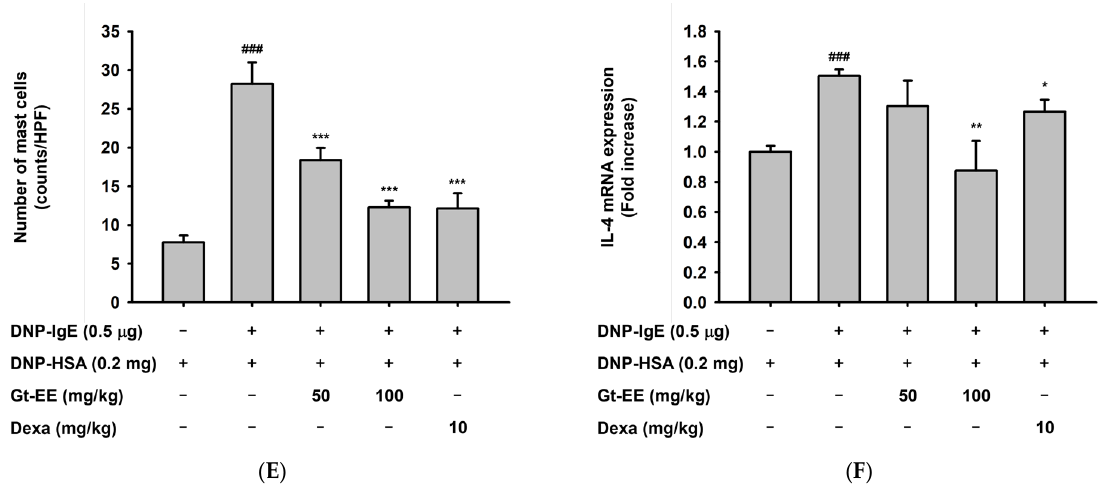
Figure 3. Effects of Gt-EE on PCA. ( A ) Experimental procedure for induction of PCA. Anti-DNP IgE and DNP-HSA were administered to the ears of BALB/c mice to induce PCA, and then the ears were stained with Evans blue dye. Gt-EE was orally administered every day for 5 days before PCA induction. Dexamethasone was used as the positive control. After euthanasia, the ears were dissected and soaked in formamide for extravasation of the Evans blue dye or fixed for histopathological analysis; ( B ) photographs of the Evans blue – stained ears and ear tissues stained with hematoxylin and eosin (H&E) or toluidine blue O. Histopathological variations and alterations in the mast cell counts due to IgE – antigen induction were assessed using H&E and toluidine blue O staining, respectively. The red arrows indicate toluidine blue O – stained mast cells; ( C ) absorbance of Evans blue extravasated from the mouse ears. Absorbance was measured at 620 nm. ( D ) The change in ear thickness was investigated using dial thickness gauges (PEACOCK, Japan). ( E ) The number of mast cells in the ear tissue was counted under a microscope at 400× magnification. ( F ) The mRNA expression of IL-4 in the mouse ears was measured using real-time PCR. After euthanasia, the ears were dissected and ground, and then total RNA was isolated for real-time PCR. ( C – F ) The results are presented as the mean ± standard deviation. ### p < 0.001 compared with the normal group, and * p < 0.05, ** p < 0.01, *** p < 0.001 compared with the control group.